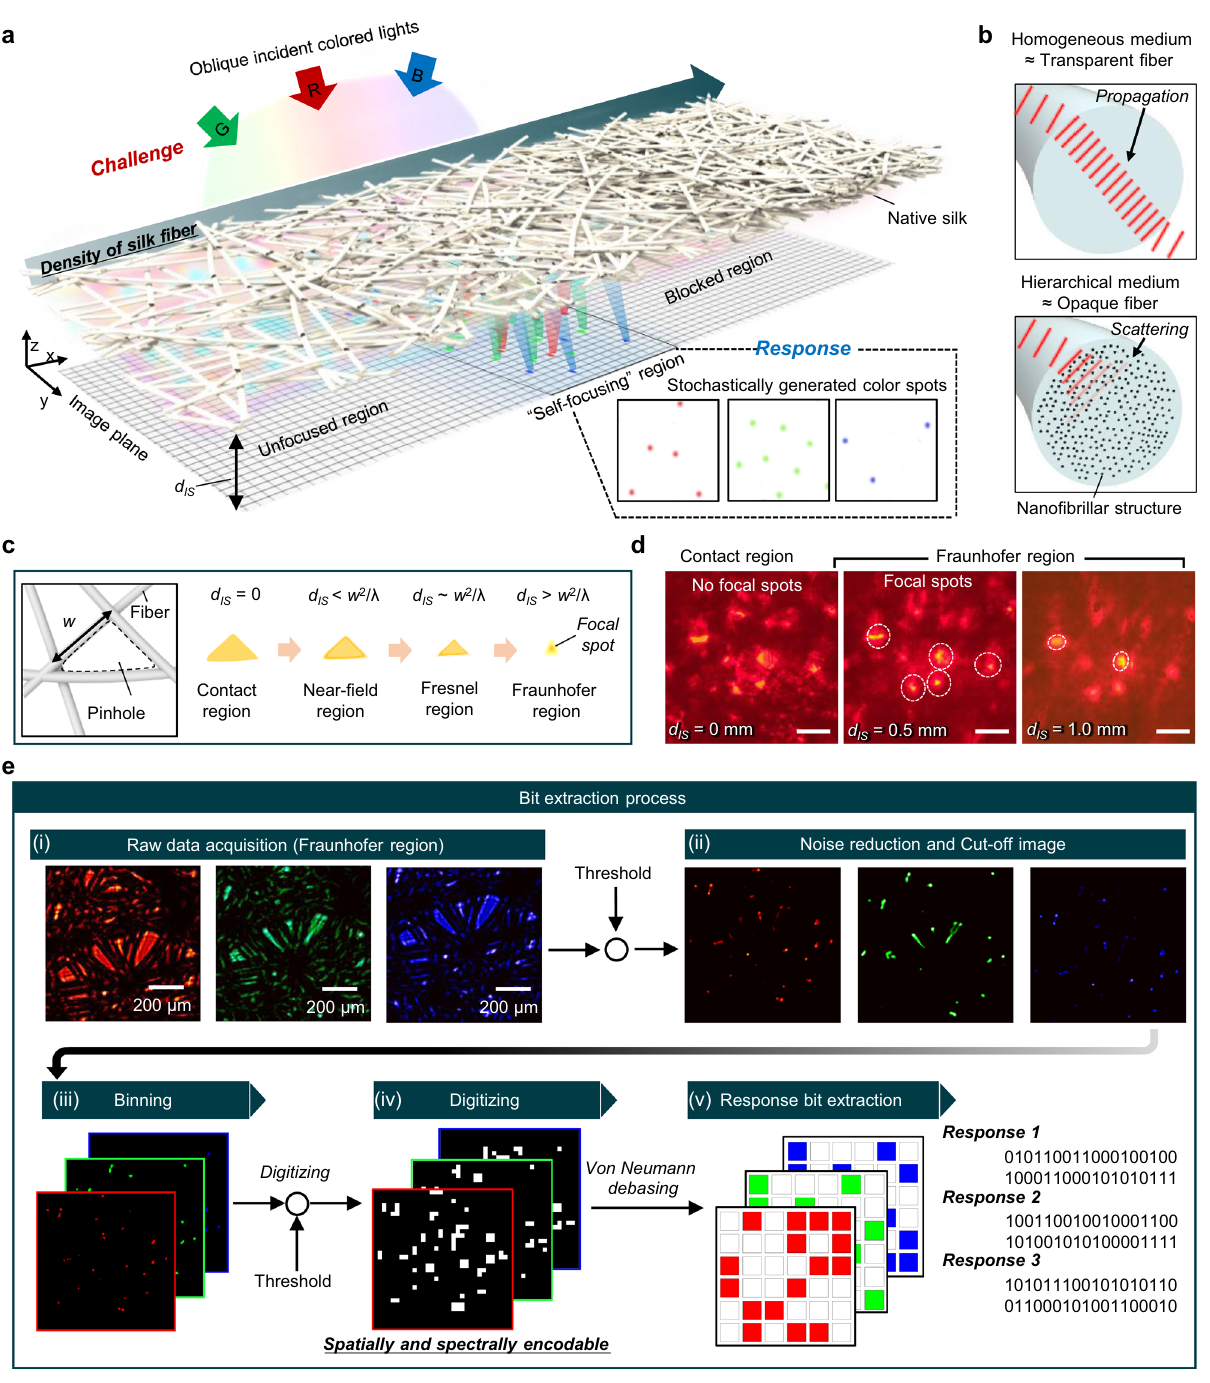
Fig. 1 Native silk features: self-focusing and unique bit extraction. a Schematic illustration of native silk with a ‘ self-focusing ’ feature caused by diffraction. The diffraction manifested depending on the micro fi ber density; low and high density of fi bers could not produce a self-focused feature due to too large or small pinhole sizes. However, the ‘ self-focusing ’ region creates stochastic and unique color spots on an image plane. b Schematic illustration for a (top) transparent fi ber and (bottom) opaque fi ber due to the nano fi brillar structures found in native silk. c Operating principle of the self-focusing effect. Randomly distributed fi bers form a stochastic pinhole, which causes diffraction. ‘ d IS ’ , ‘ w ’ , and ‘ λ ’ are the distance between the fi ber pinhole and image plane, the width of the fi ber pinhole, and the incident wavelength, respectively. In the Fraunhofer region (i.e., d IS > w 2 / λ ), the diffracted light is self-focused. d Obtained image with a red LED at three distances (0, 0.5, and 1.0 mm). The scale bar is 100 μ m. e Description of the bit extraction process, involving: (i) raw data acquisition, (ii) noise reduction and cut-off image generation, (iii) binning, (iv) digitization, and (v) response bit creates a wide spot region from 0.3 to 0.9 mm at a wavelength of light encounters a fi ber, the light experiences diffraction. The 645 nm. The maximum intensity of the focal spot (i.e. , Spot max ) interference of the diffracted light creates a self-focusing region, appears at a Z position of 0.45 mm. This long spot region allows i.e. , Z focused , de fi ned from Spot start to Spot end . The simulated result shows that the fi ber with an opening diameter ( D ) of 35 μ m the removal of a lens element to form strong light spots on an